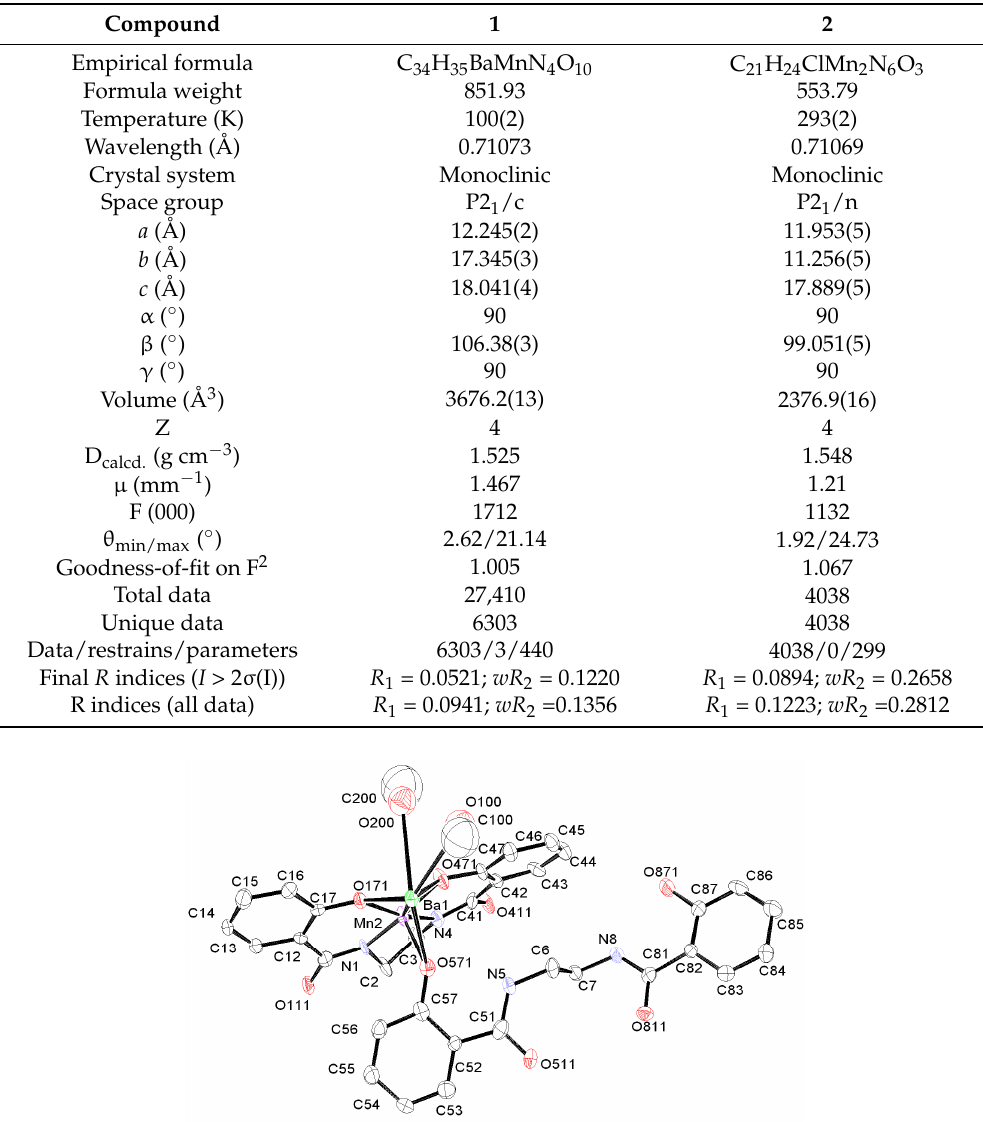
Table 1. Crystal data and structure refinement parameters for compounds 1 and 2 .